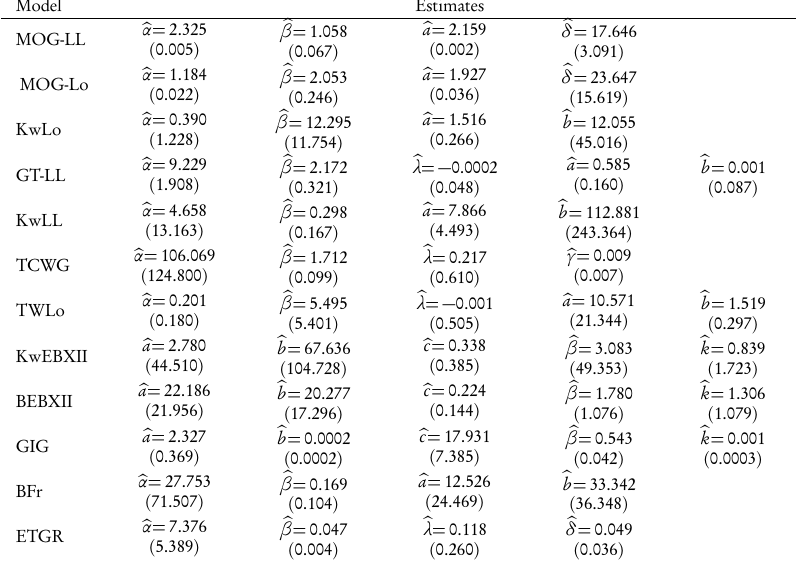
MLEs and their standard errors (in parentheses) for cancer